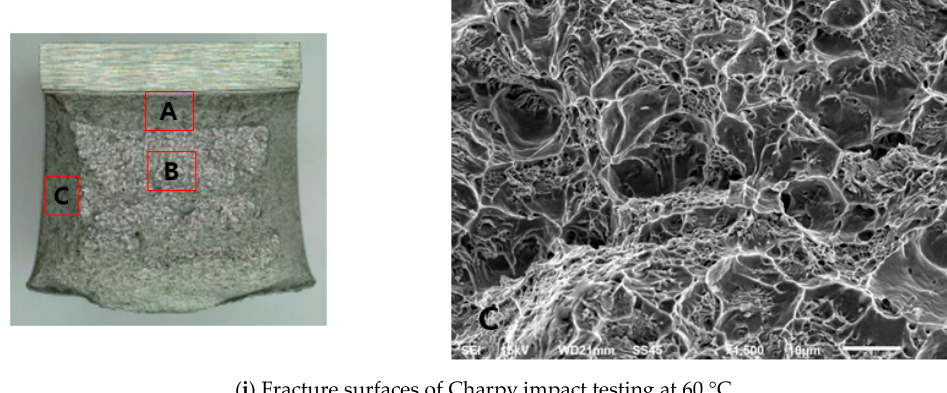
Figure 12. Images of fracture surfaces taken with a scanning electronic microscope.